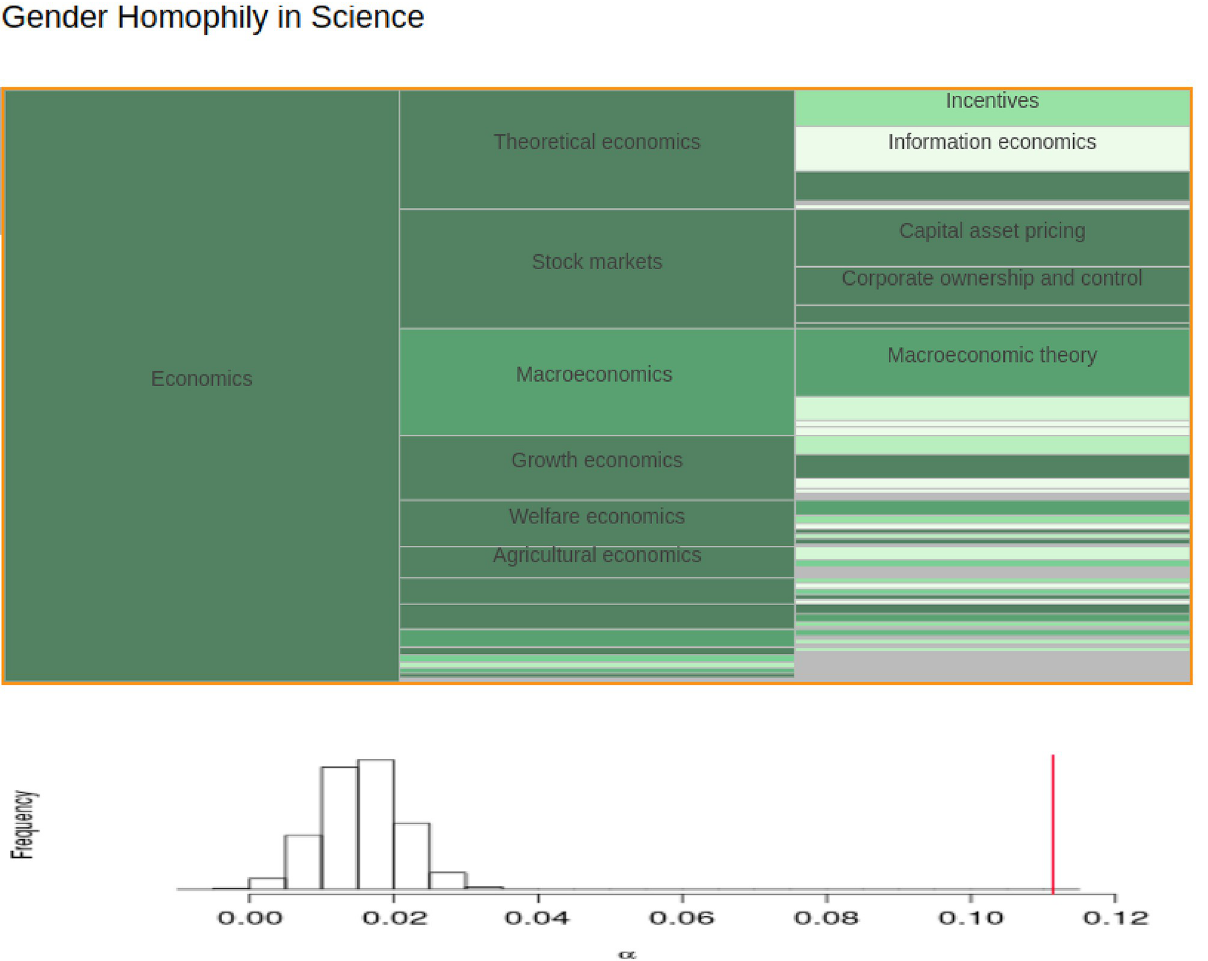
Fig 3. Gender homophily across sub-disciplines. The top figure shows the hierarchical clustering of economics; the height of each rectangle indicates the size relative to the top-level field and a darker shade of green indicates a smaller p-value. The bottom panel shows the histogram of α values when accounting for structural and compositional effects (i.e., the null distribution) with the observed α value indicated by the vertical red line. An interactive version of this figure for exploring other disciplines can be found in the online browser.